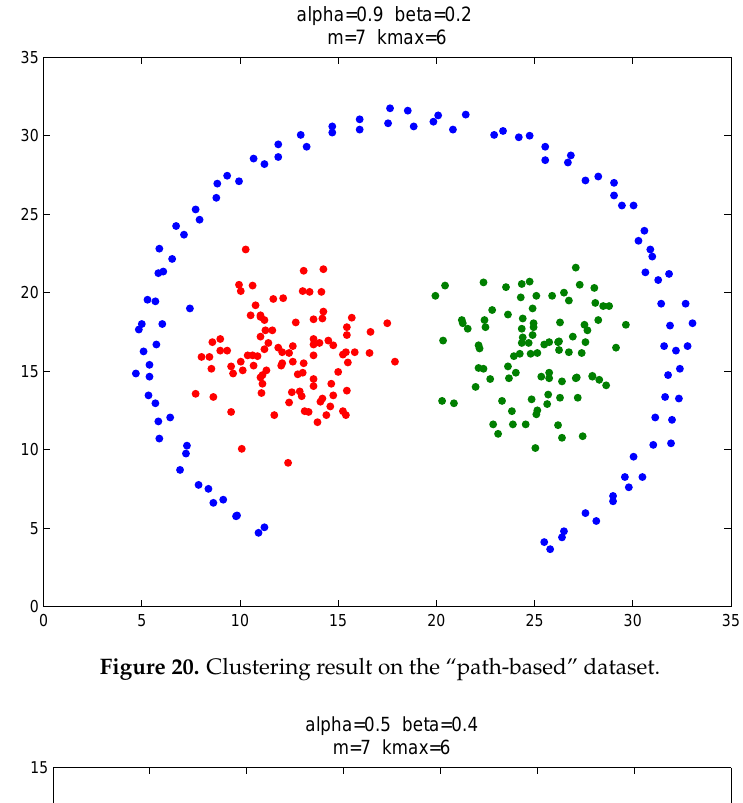
Figure 20. Clustering result on the “path-based” dataset.